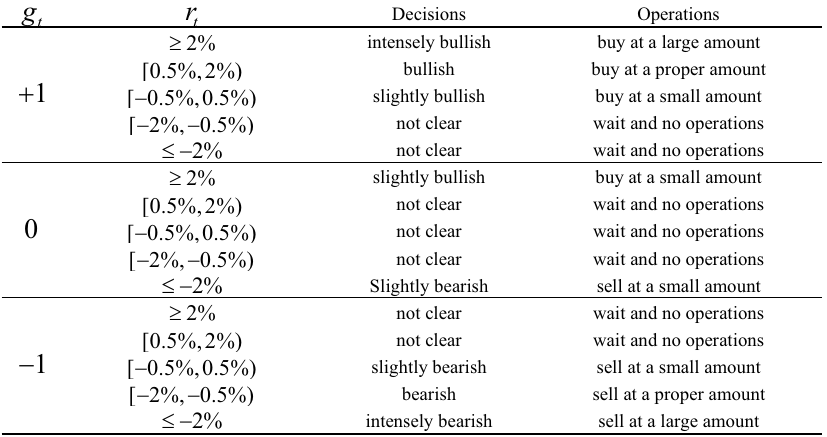
Table 3. Comprehensive predicting rules and corresponding